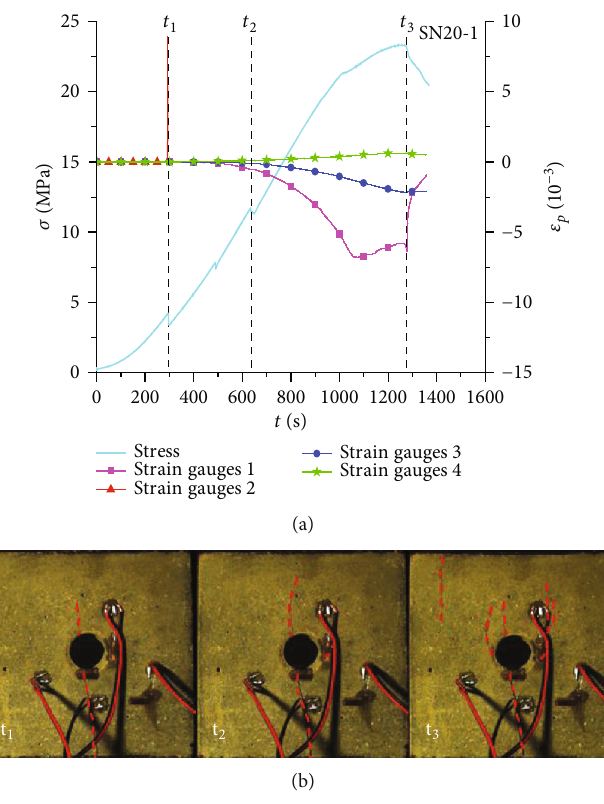
Figure 13: (a) Relationship between local strain and stress of specimen SN20-1 with loading time. (b) The relationship between the crack growth shape of specimen SN20-1 and loading